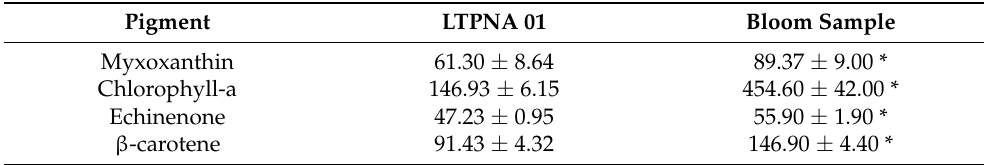
Table 3. Pigments content in the cells of the LTPNA 01 strain and the bloom sample: myxoxanthin, echinenone, chlorophyll-a, and β -carotene by dry weight (nmol/g of DW). Pigment LTPNA 01 Bloom Sample Myxoxanthin 61.30 ± 8.64 89.37 ± 9.00 * Chlorophyll-a 146.93 ± 6.15 454.60 ± 42.00 * Echinenone 47.23 ± 0.95 55.90 ± 1.90 * β -carotene 91.43 ± 4.32 146.90 ± 4.40 * Asterisk marks (*) indicate significant differences between the bloom sample and LTPNA 01